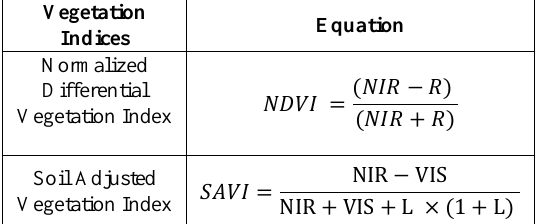
Table 3. The vegetation indices used in this study.